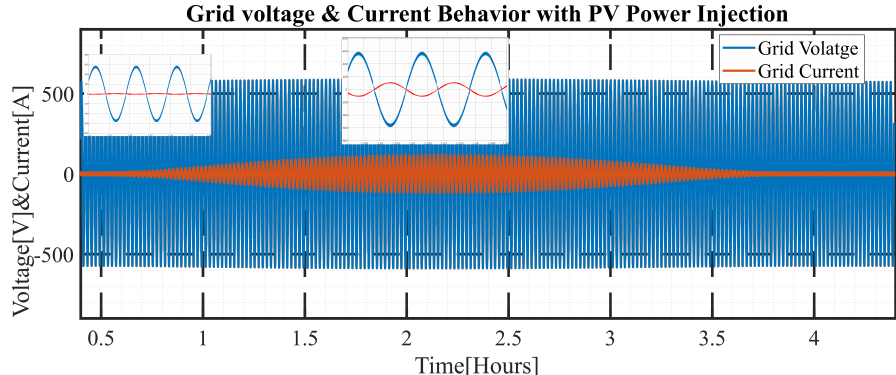
Figure 23. Grid voltage and current with PV Power injection.